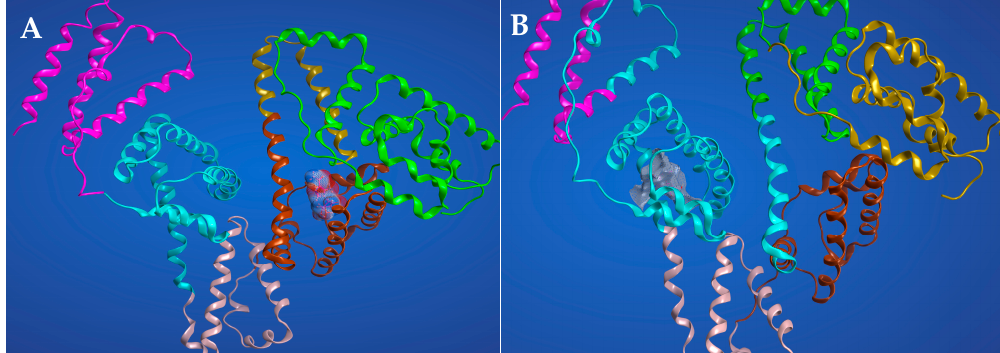
Figure 8. The best-scoring ribbon renditions for the AICAR–HSA complexes in Sudlow’s site I ( A ) and in Sudlow’s site II ( B ).